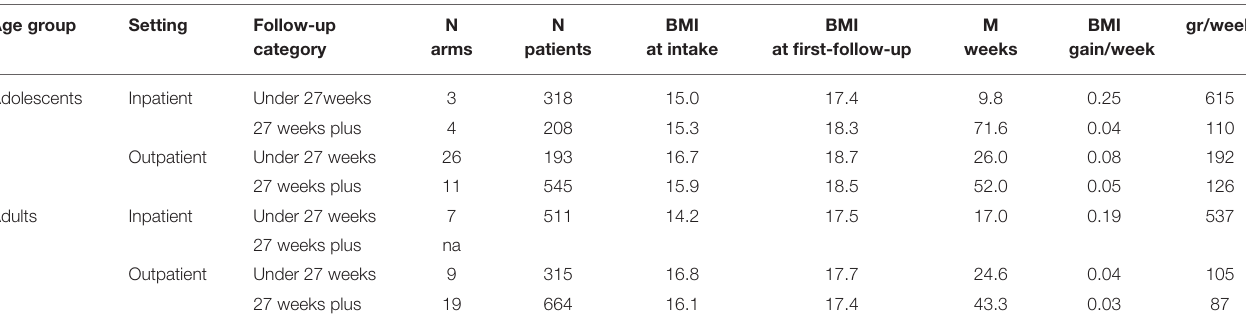
TABLE 4 | Estimates of weight